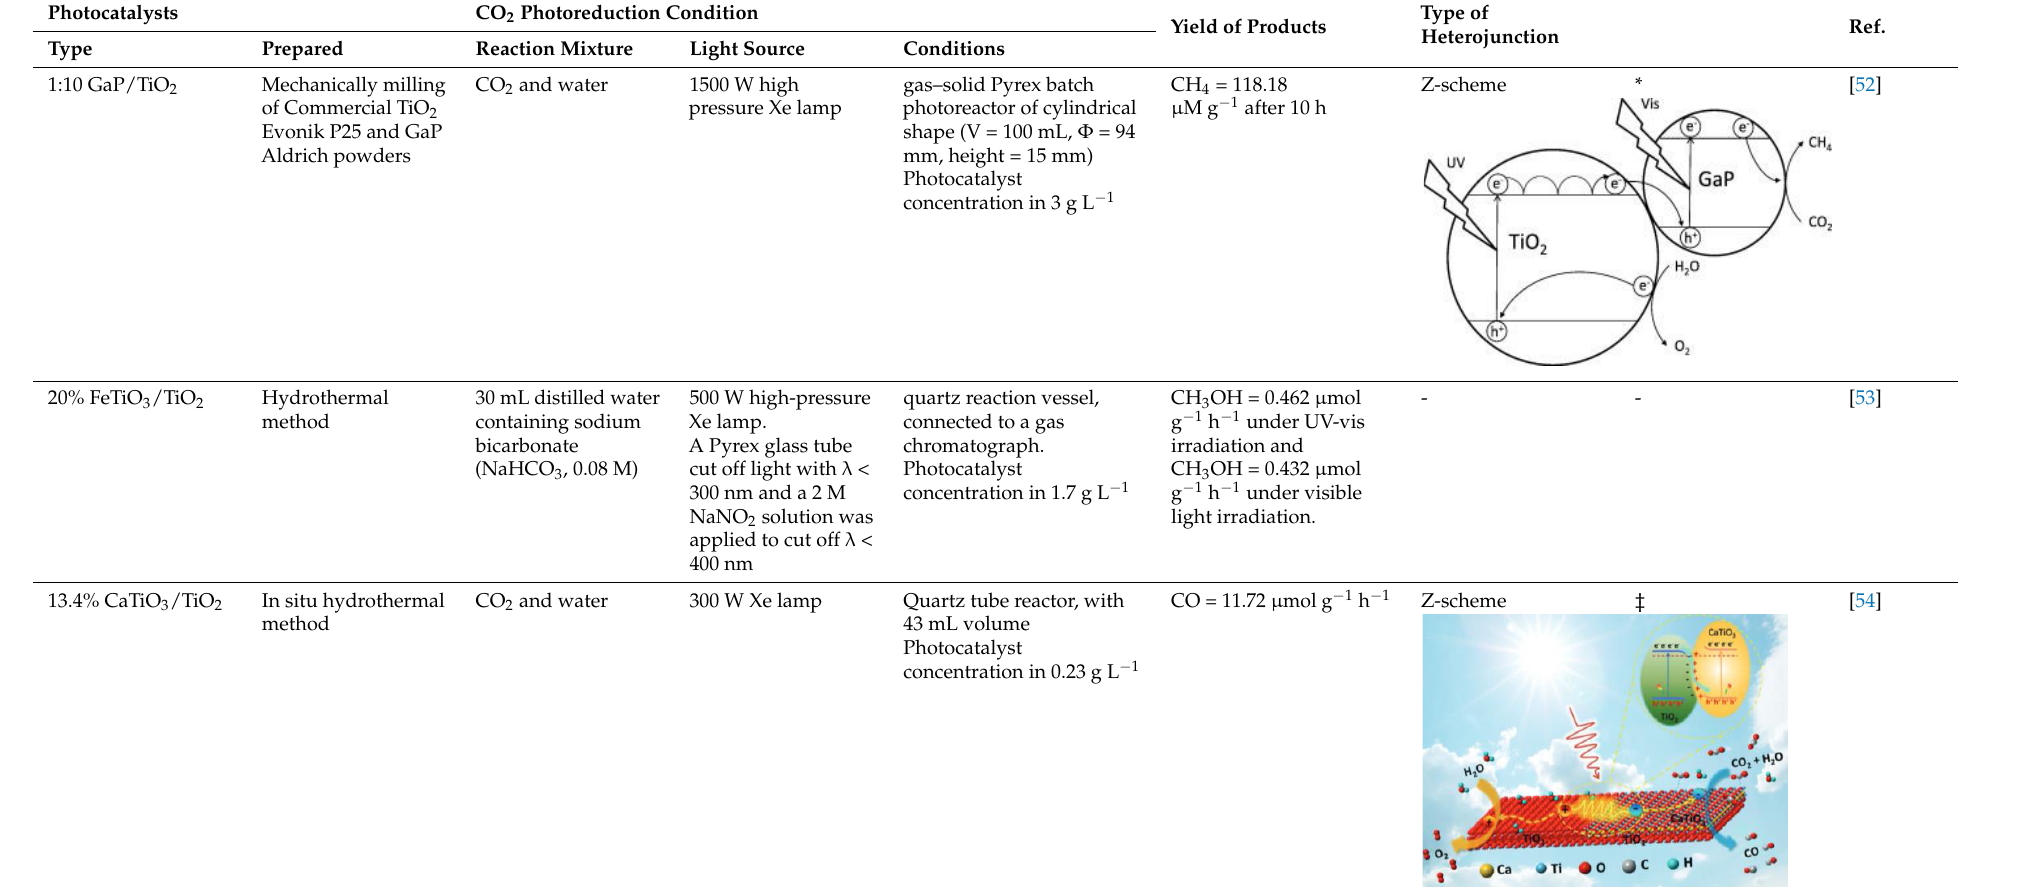
Table 7. CO 2 photoreduction using GaP/TiO 2 , CaTiO 3 /TiO 2 and FeTiO 3 /TiO 2 heterojunction photocatalysts.